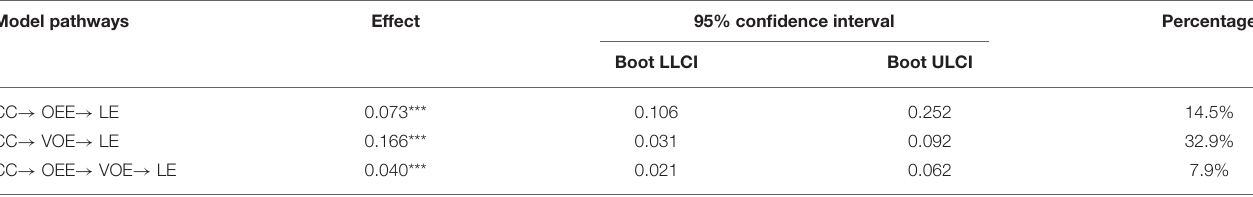
TABLE 2 | Bootstrap analyses of significance of mediation (controlling for gender and